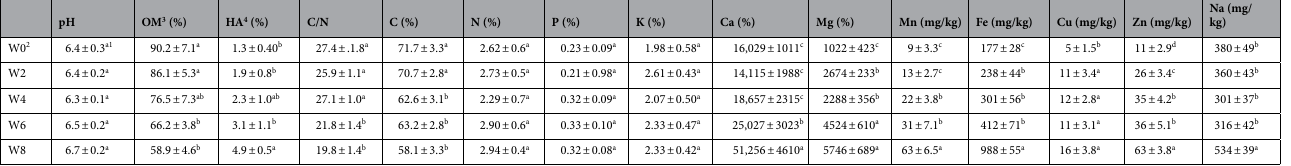
Table 5. The chemical properties of lemon peel compost at different sampling stage. 1 Different letters indicate significantly different results by LSD tests at p < 0.05. 2 0, 2, 4, 6, 8 week after compost. 3 Organic matter. 4 Humic